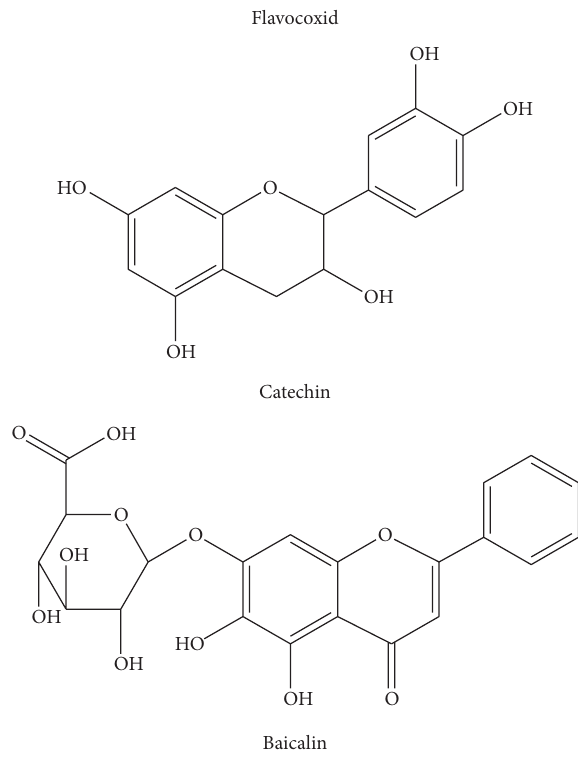
Figure 2: Flavocoxid components: catechin and